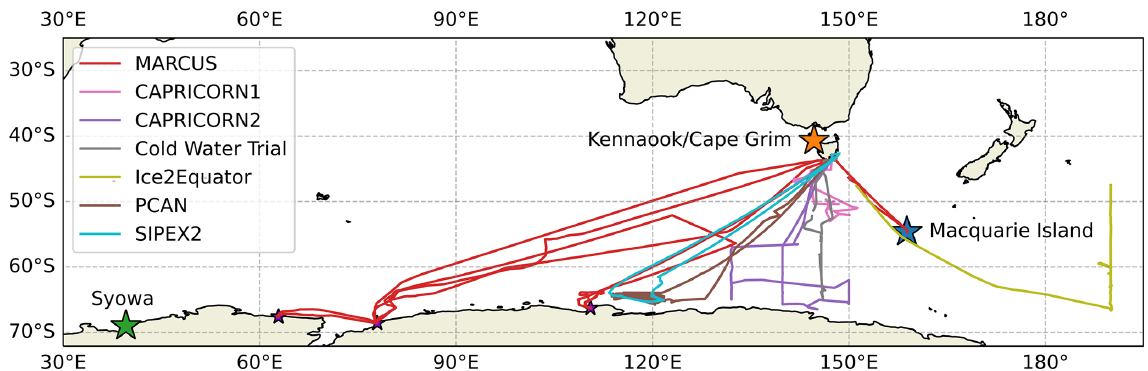
Figure 1. Map showing the relative locations of the three long-term stations utilised in this study: Kennaook / Cape Grim (40.7 ◦ S, 144.7 ◦ E), Macquarie Island (54.5 ◦ S, 159.0 ◦ E) and Syowa (69.0 ◦ S, 39.6 ◦ E). Voyage tracks of those voyages utilised in this study are also shown. Both SIPEX2 and MARCUS occurred aboard ice breaker RSV Aurora Australis , with the latter occurring throughout a full season of four resupply voyages to Australian Antarctic stations (from west to east: Mawson, Davis, Casey (all shown as black stars) and (labelled) Macquarie Island). Note that data from the Ice2Equator voyage have been sub-selected ( > 47 . 5 ◦ S) for those likely to be representative of Southern Ocean air masses unaffected by New Zealand continental influence or tropical air further